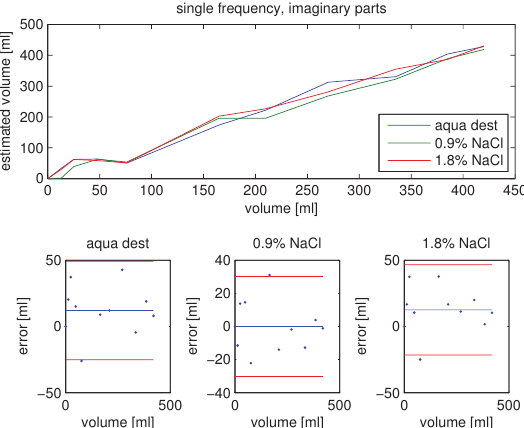
Fig.13: In-vitro results for single-frequency variant using imagin- ary parts: good suppression of urine conductivity variation in the volume estimation